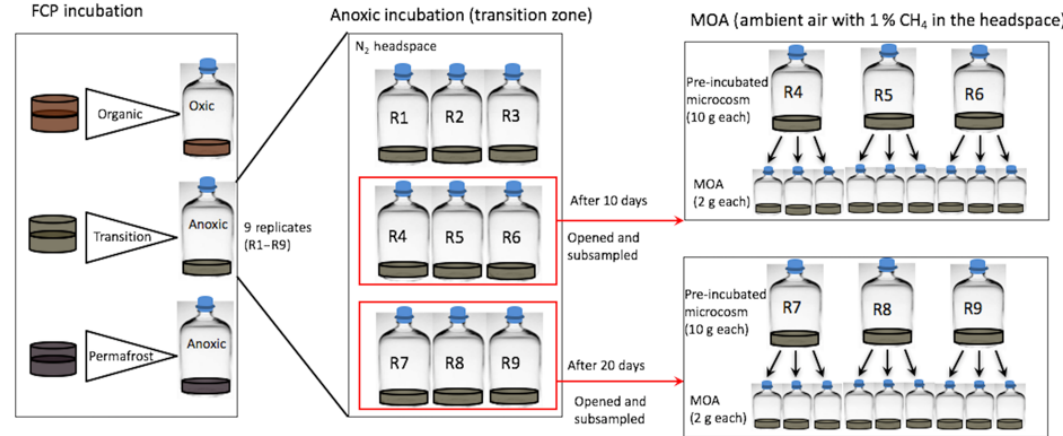
Figure 1. Soil incubation and methane oxidation assay (MOA) experimental design. Soils from the transitional layer of a FCP core were used here to illustrate how incubations and MOAs were constructed at a given temperature. Incubation replicates were destructively sampled after 10 or 20 days to set up MOA with pre-incubated soils. For example, nine replicate microcosms were created for the FCP transition-layer soil, incubated under anoxic conditions. CO 2 and CH 4 in the headspace were cumulatively measured. After 10 days, three were opened and subsampled for triplicate MOAs. After 20 days, another three were opened and subsampled for triplicate